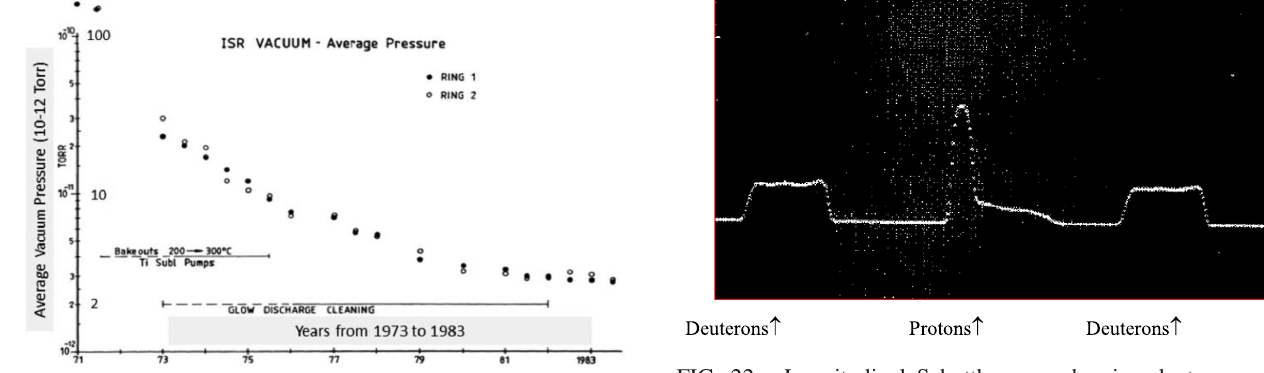
FIG. 22. Longitudinal Schottky scan showing deuterons and protons in the same vacuum chamber but occupying different frequencies in phase